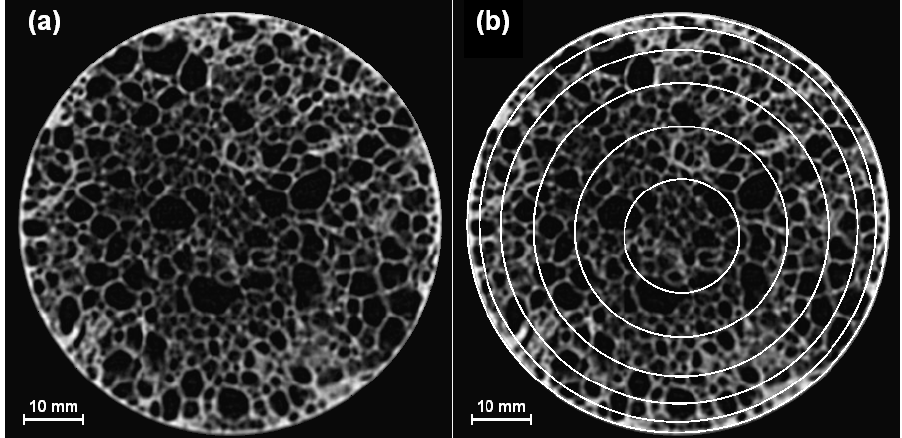
Figure 1. ( a ) Tomographic slice with ( b ) an exemplification of the SSDD method (reduced number of analyzed bands) applied in the 70/70 mm foam ( ρ = 650 kg/m 3